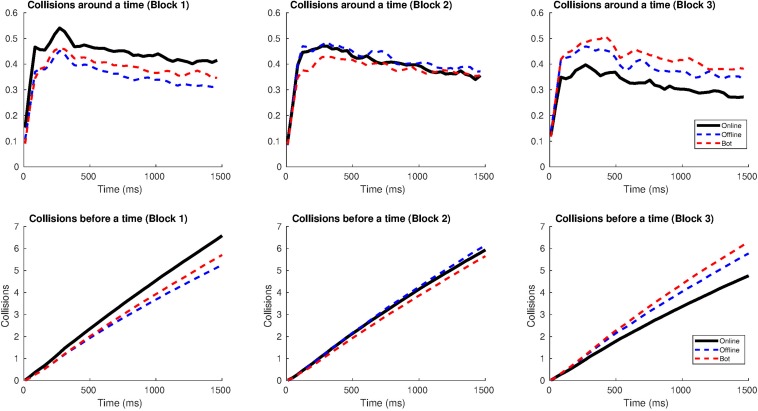
Distribution of the number of crossings as we increase the window span in Study 1. The graphs show how many crossings are produced in the window span from one crossing until a specific amount of time.